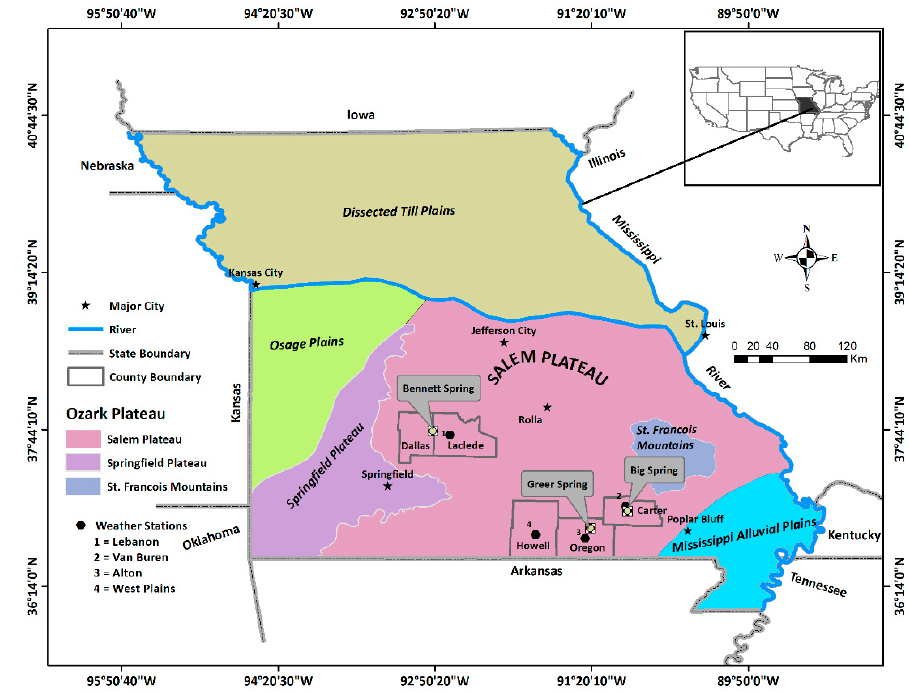
Figure 1. Map of state of Missouri showing physiographic regions and monitoring sites.